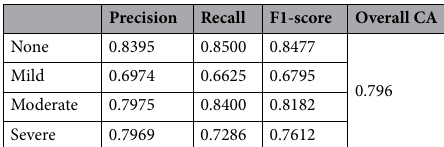
Precision Recall F1-score Overall